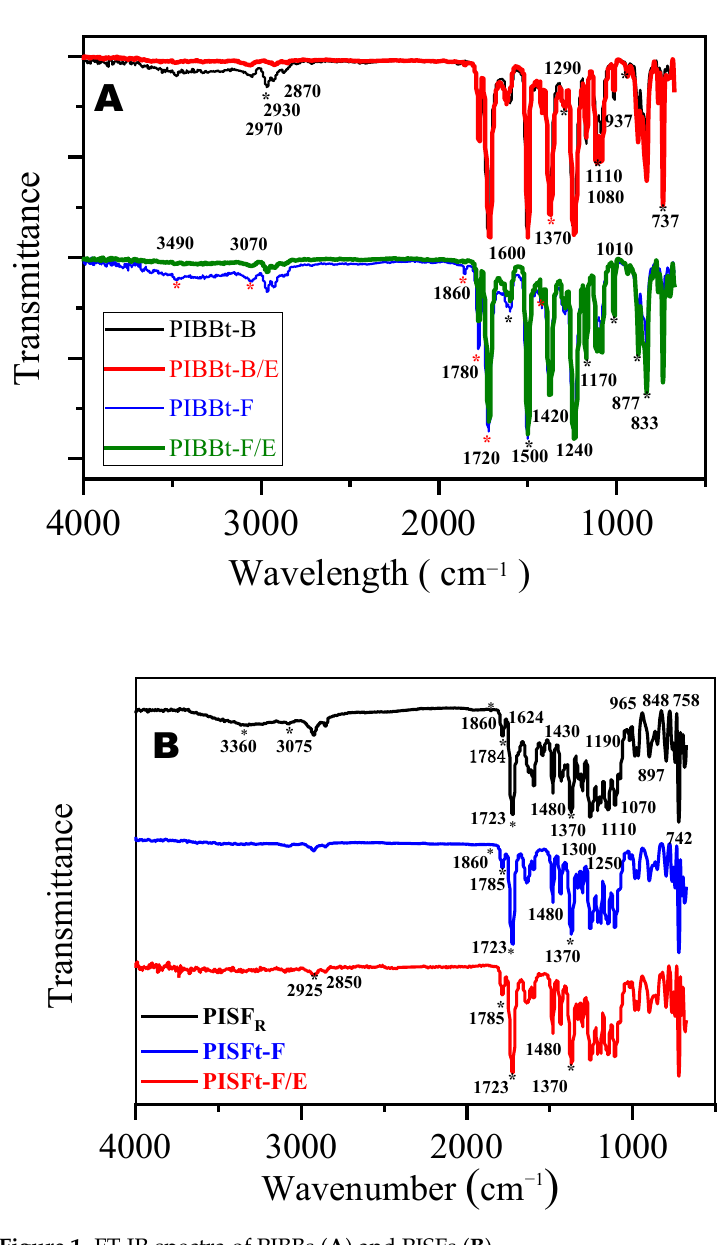
Figure 1. FT-IR spectra of PIBBs ( A ) and PISFs ( B ). Table 1. Optical performance of PIBB films after different temperature thermal treatment. Films